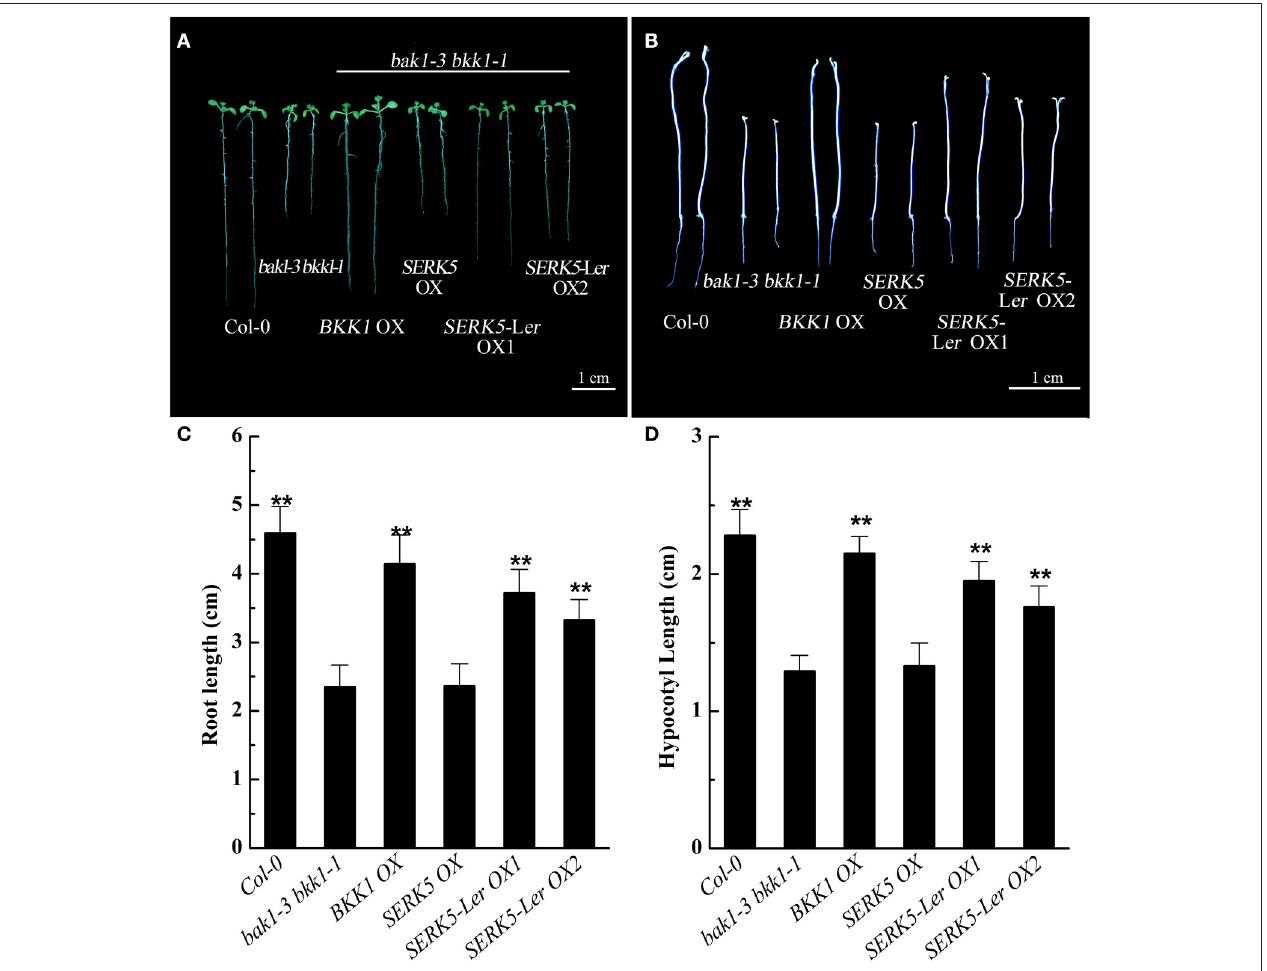
FIGURE 5 | Phenotypic analyses of bak1-3 bkk1-1 overexpressing SERKs . (A) Overexpression of SERK5 -L er elongates the root lengths of bak1-3 bkk1-1 . 8-day-old seedlings grown on 1/2 MS medium in the light were presented. (B) Overexpression of SERK5 -L er elongates the hypocotyl lengths of bak1-3 bkk1-1 . 8-day-old seedlings grown on 1/2 MS medium in the dark were presented. (C) Statistic analyses of root lengths of the plants presented in (A) . (D) Statistic analyses of hypocotyl lengths of the plants presented in (B) . The data are shown as means ± standard deviation (SD) ( n = 25 ). Student’s t -test indicated the differences are statistically significant ( ** P < 0.01 ). Experiments were repeated three times with similar results.